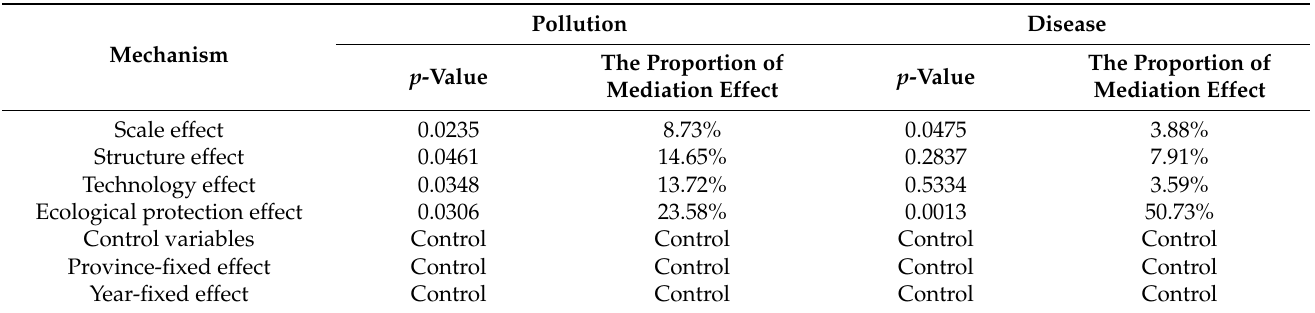
Table 7. Sobel test.